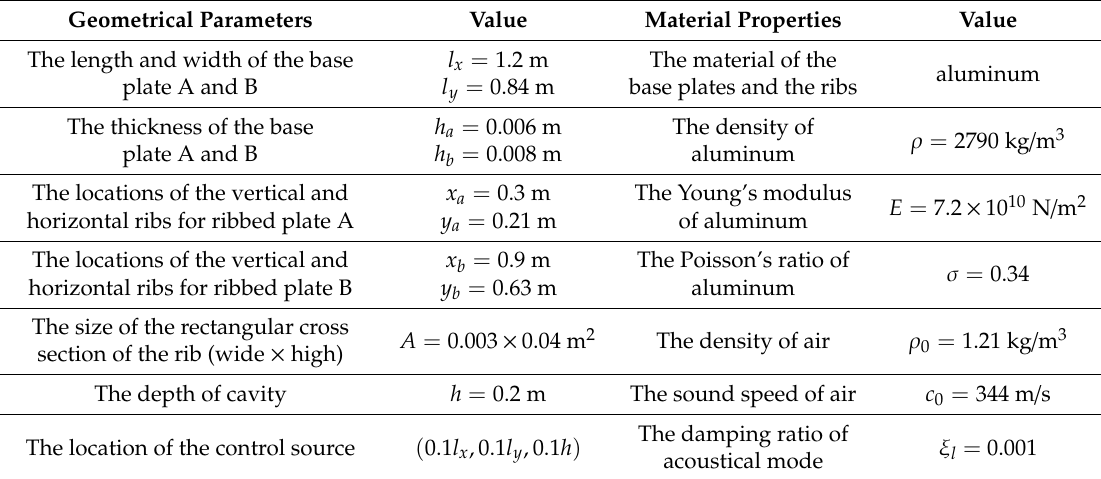
Table 1. The geometrical parameters and material properties of the system.